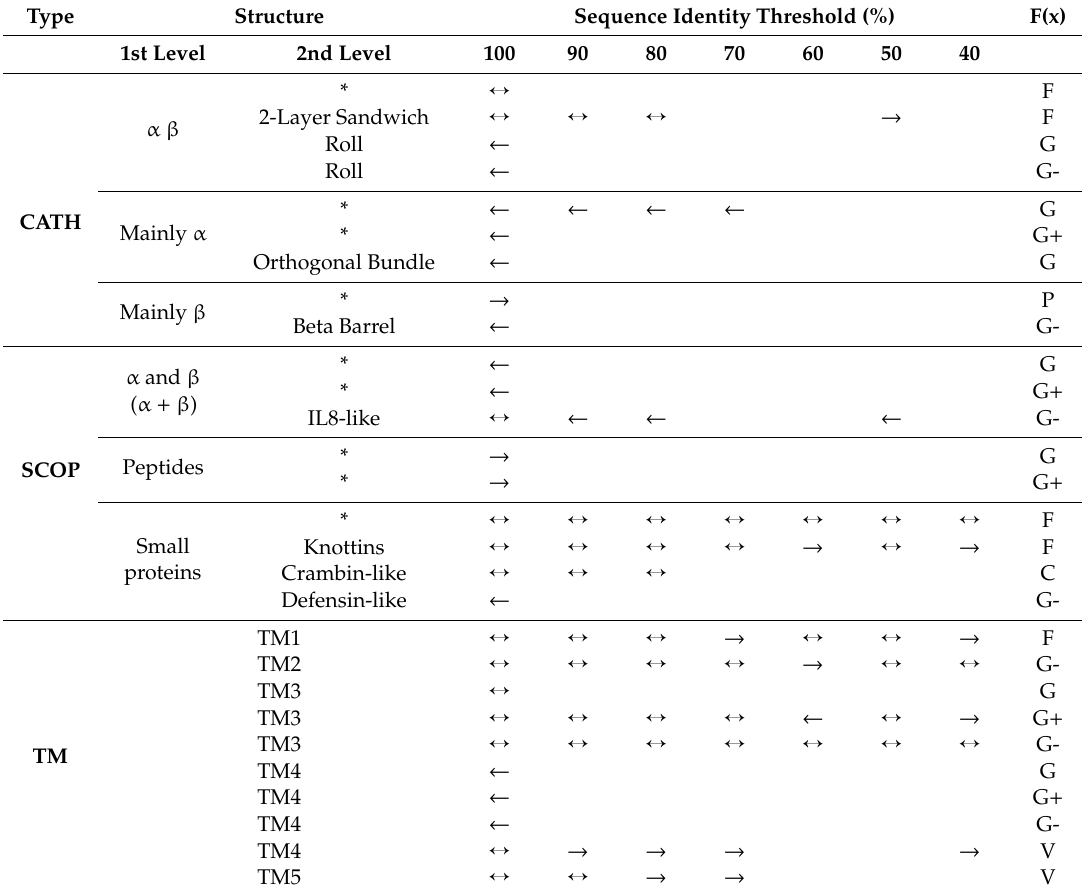
Table 1. Significant enrichments between functions and structures of antimicrobial peptides. Type